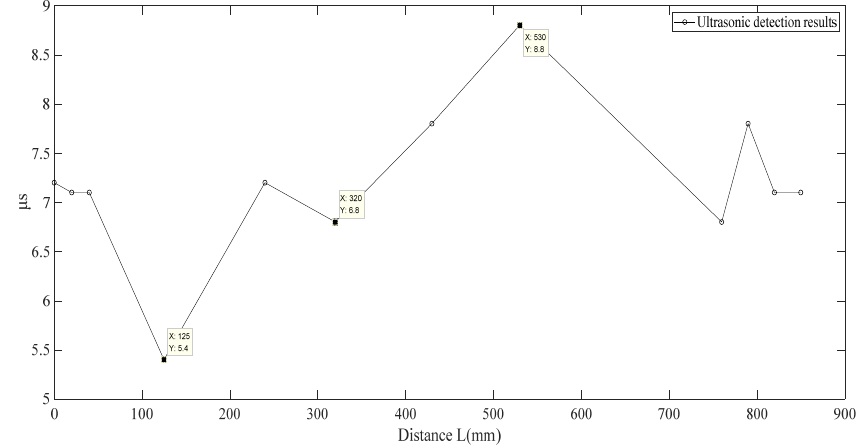
Figure 5. Ultrasonic detection results.